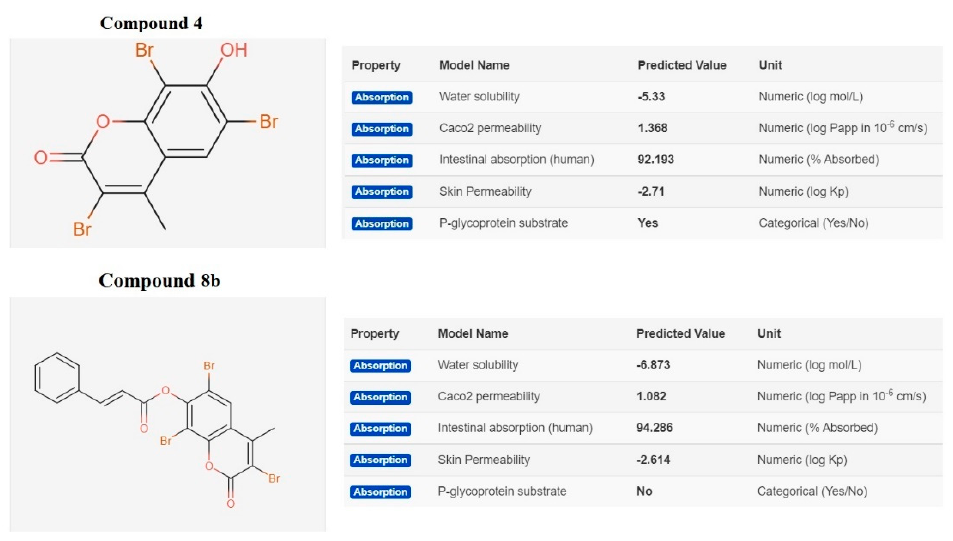
Figure 15. Compounds ( 4 ) and ( 8b ) predicted P-glycoprotein substrates using the pkCSM website tool.